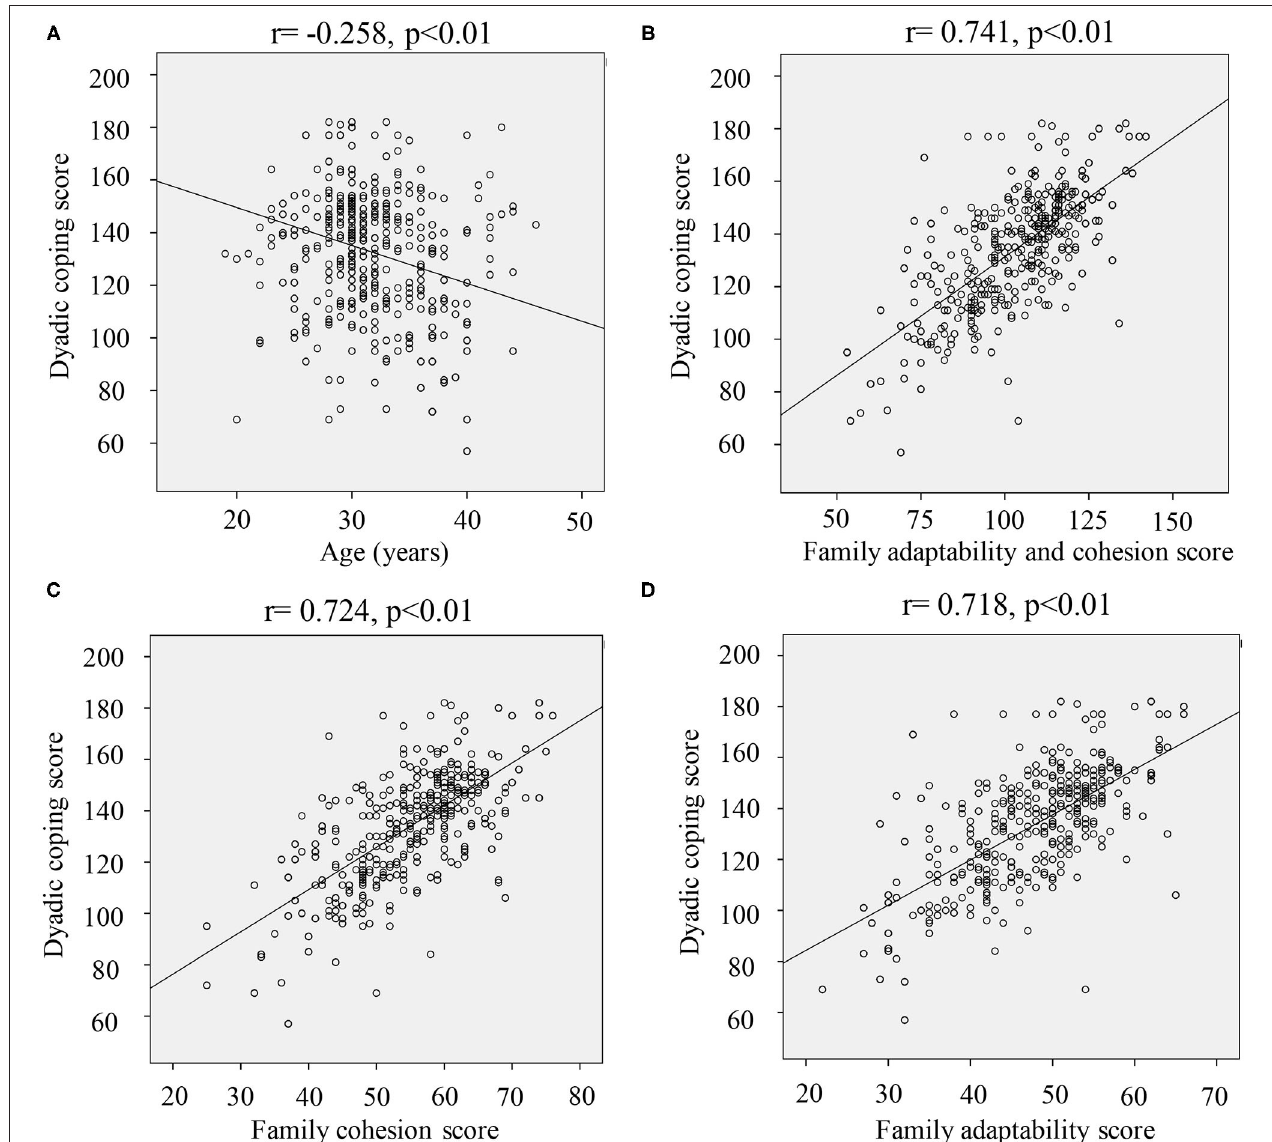
FIGURE 1 | Correlation analysis of the dyadic coping score and other factors. (A) Correlation analysis of dyadic coping and age; (B) correlation analysis of dyadic coping and family adaptability and cohesion; (C) correlation analysis of dyadic coping and family cohesion; (D) correlation analysis of dyadic coping and family